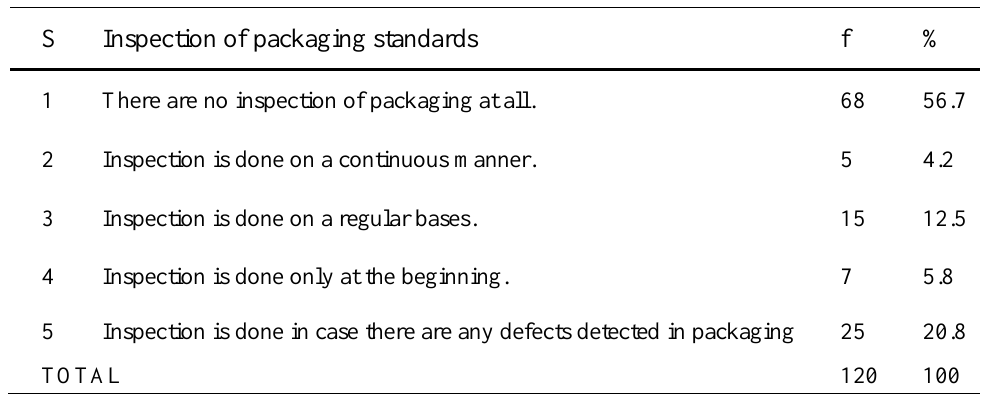
Table 3. Response towards